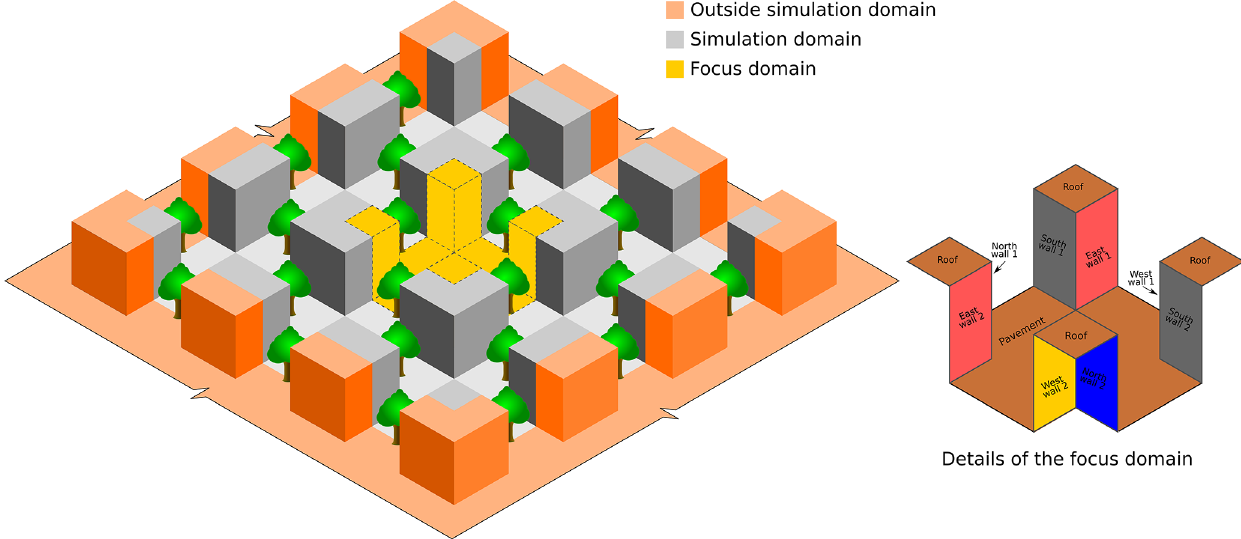
Figure 1. Illustration of the simple urban configuration showing the simulation and the focus domain. The trees (shown in green) are centred between buildings.